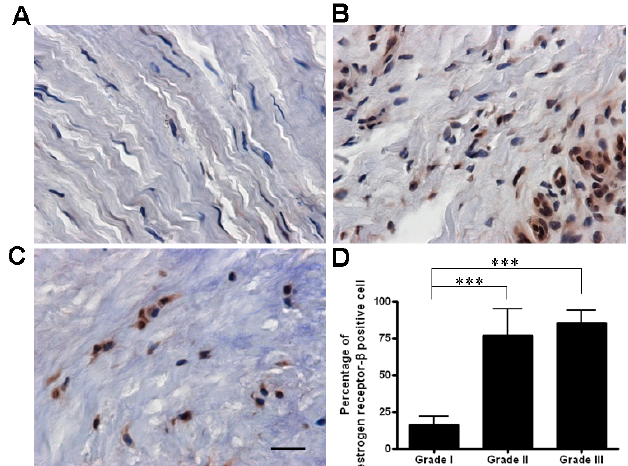
Figure 2. The percentage of ER- β -positive cells in grade I samples ( A ) was lower than in grade II ( B ) and grade III ( C ) samples (immunohistochemical staining, 400× magnification, scale bar = 10 μ m); and ( D ) There were significantly more ER- β -positive cells in grade II and grade III areas than in grade I areas. The positive percentage was calculated as: (number of positive cells/total cells) × 100%. Data are mean ± standard deviation. *** p < 0.001.